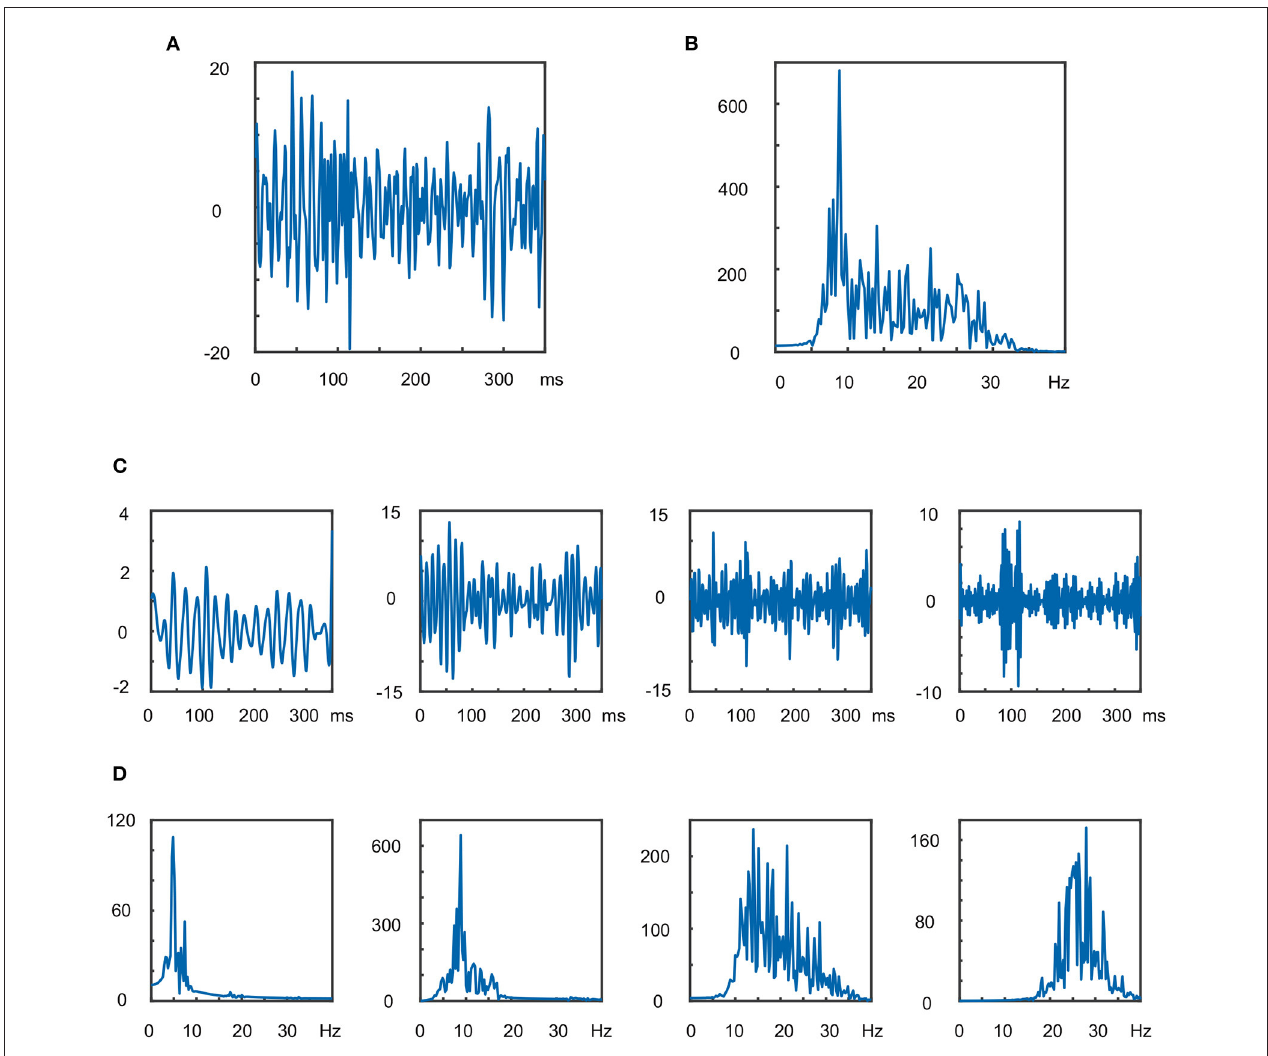
FIGURE 2 | The 100th trial of the training data set from subject al implemented by DB7 where the level of wavelet decomposition is three: (A) waveform in time domain after 7–40 Hz band-pass filtering; (B) amplitude waveform in frequency domain; (C) amplitude waveforms of the four sub-band components in the time domain; (D) amplitude waveforms in the frequency domain of the four sub-band